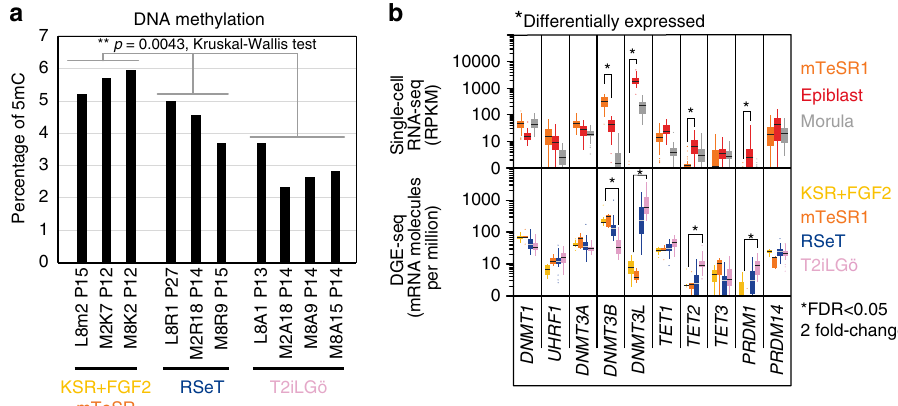
Fig. 4 T2iLGö hiNPSCs are hypomethylated. a T2iLGö hiNPSCs are hypomethylated in comparison to their RSeT and KSR+FGF2 counterparts. 5mC content is expressed as the percentage of 5mC in the total pool of cytosine for the indicated cell lines. Signi fi cance level was determined using Kruskal – Wallis test ** p < 0.01. b Expression of indicated epigenetic-related genes is plotted as RPKM for single-cell RNA-seq or mRNA molecules per million of total mRNA molecules for DGE-seq. Error bars are de fi ned as s.e.m. *Differentially expressed gene, as de fi ned